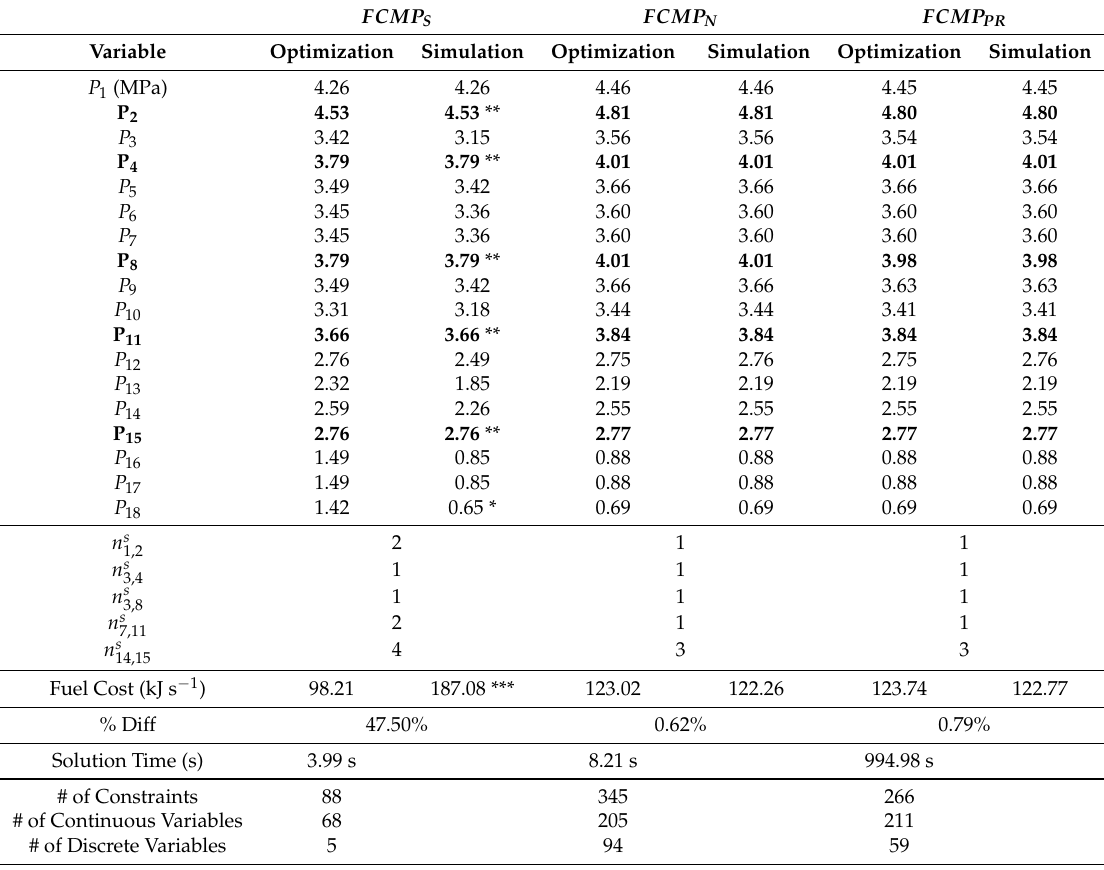
Table 5. Example 3 case study results. Lines in bold represent outlet pressures from compressor stations.